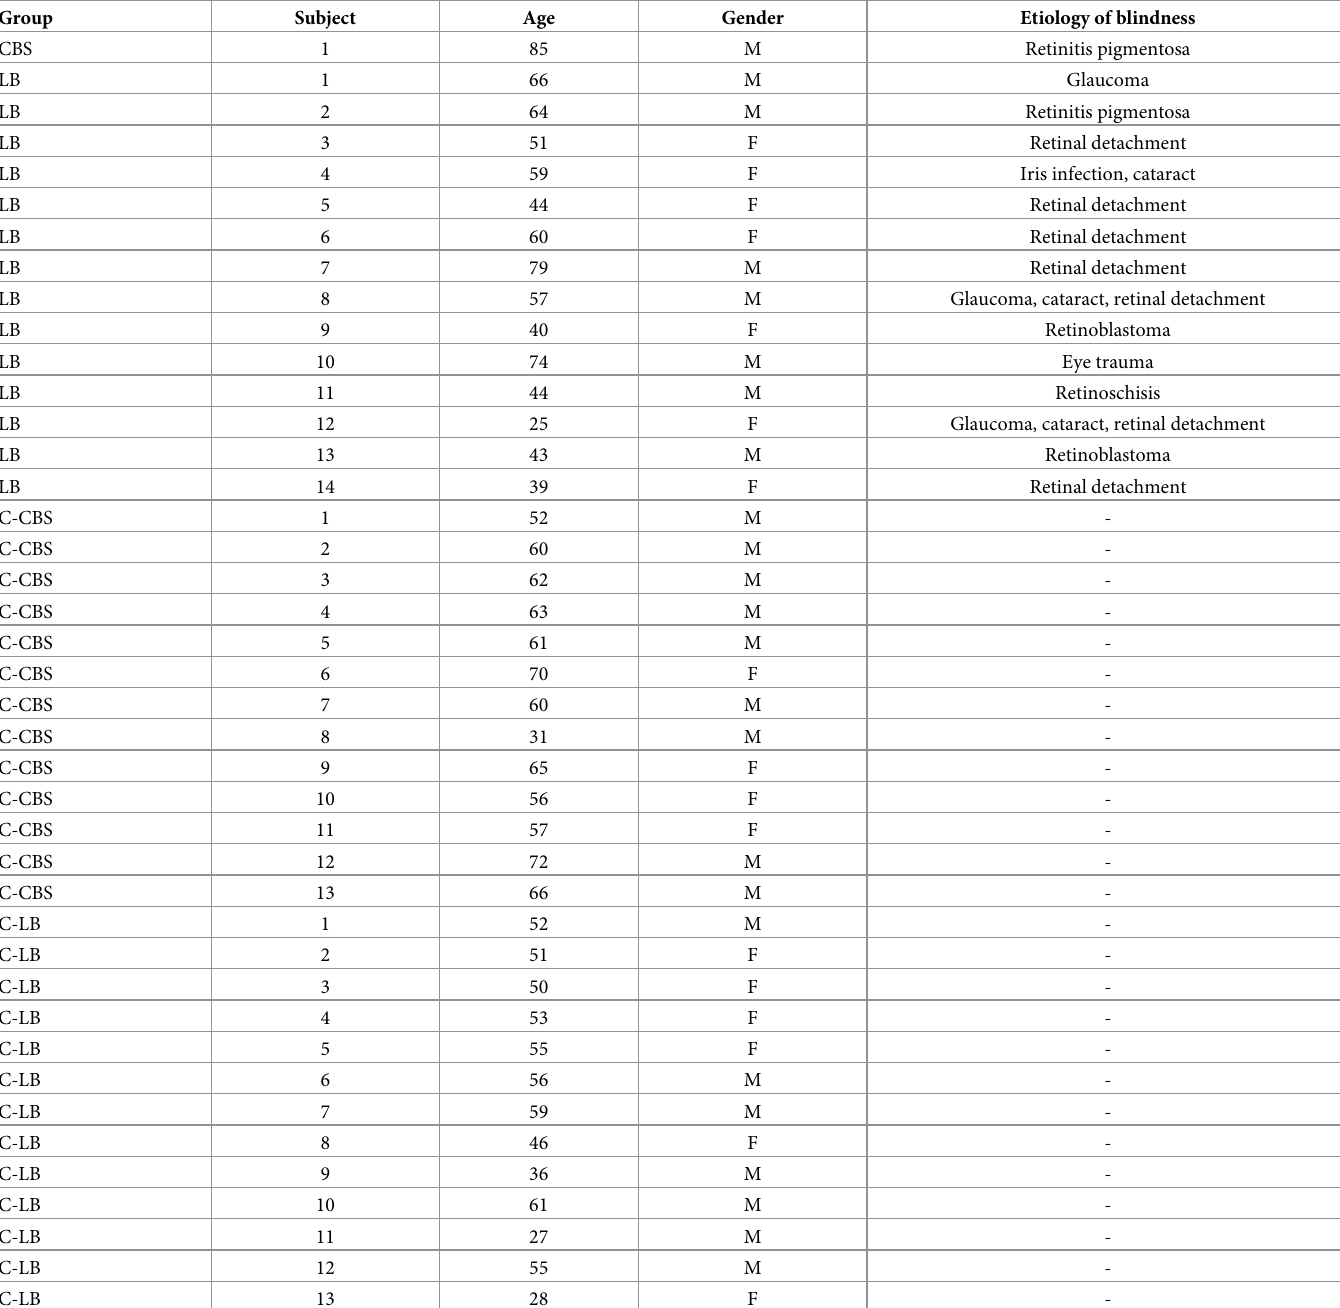
Table 1. Demographic details per